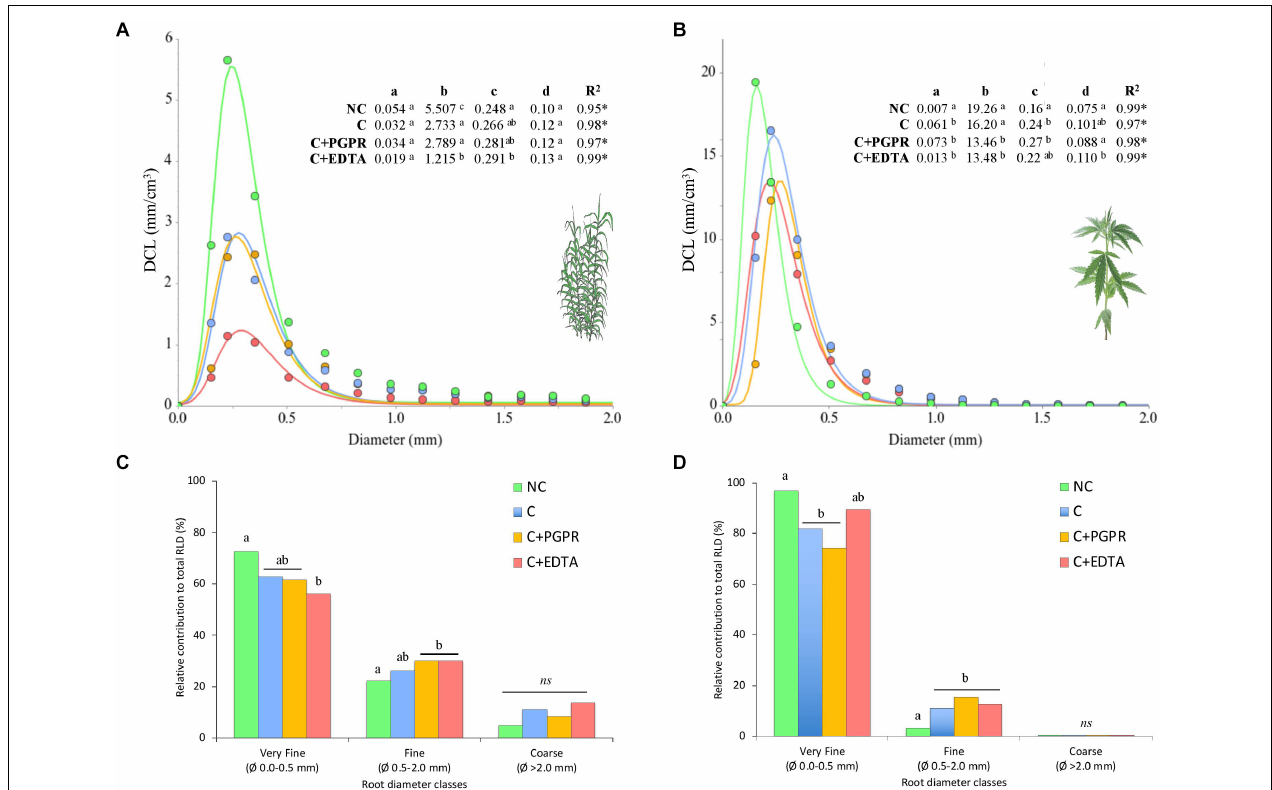
FIGURE 4 | Diameter class length (DCL, mm cm − 3 ) distribution of hemp (A) and giant reed (B) whole root systems and (C , D) relative contribution (%) of the very fine, fine, and coarse roots to the total root length density (RLD). Coefficients and statistics obtained from the regression of extreme value model are reported in the table where the statistical significance of the DCL curve parameters ( a – d ) were assessed through testing their standard errors using the t-statistics at P < 0.05. Different letters in graph (C , D) denote statistical differences (Tukey’s test, P = 0.05) among treatment for each root diameter classes.